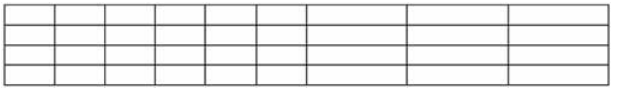
Fig. 4. Initial shape with coarse mesh of the cantilever beam.